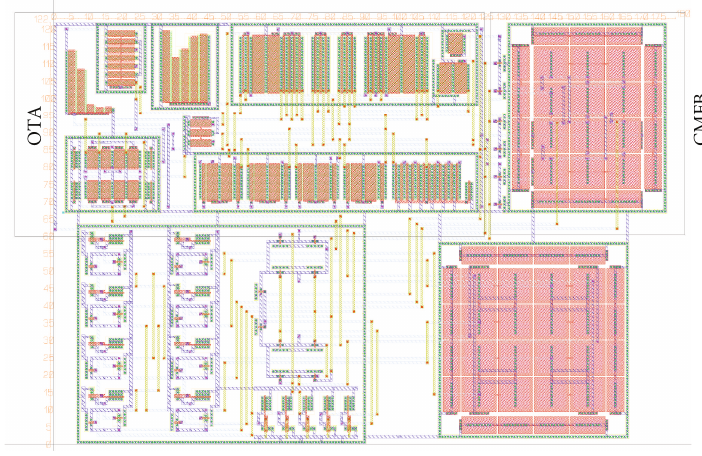
Figure 23: S&H layout.